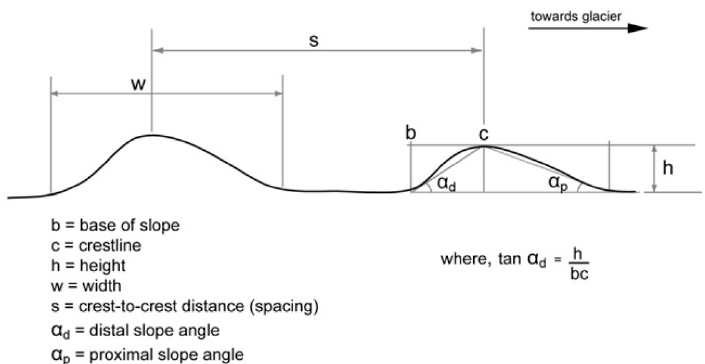
Figure 3. Schematic showing of measurement and calculation of the morphometric parameters of ridges crests, e.g., push moraines. We used: height (h), width (w), slope angles (alpha), and spacing (s) [17].